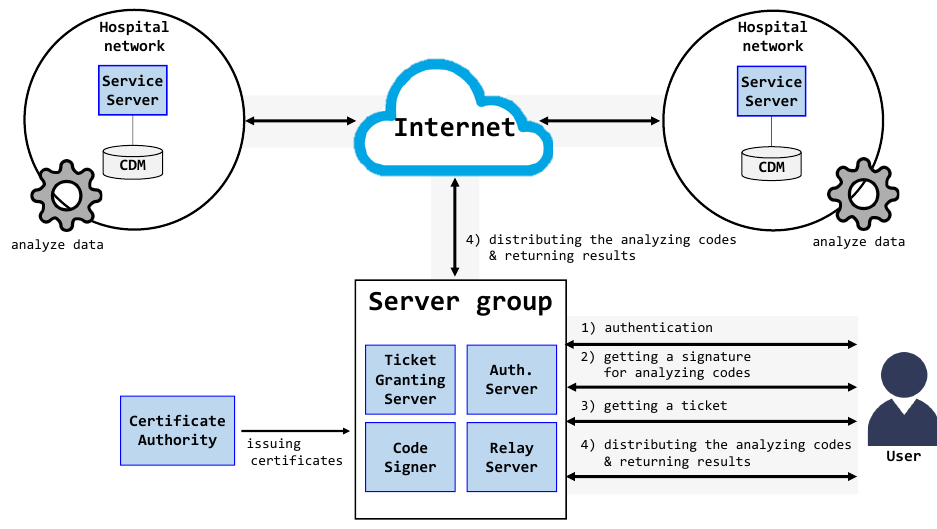
Figure 1. Operating environment of